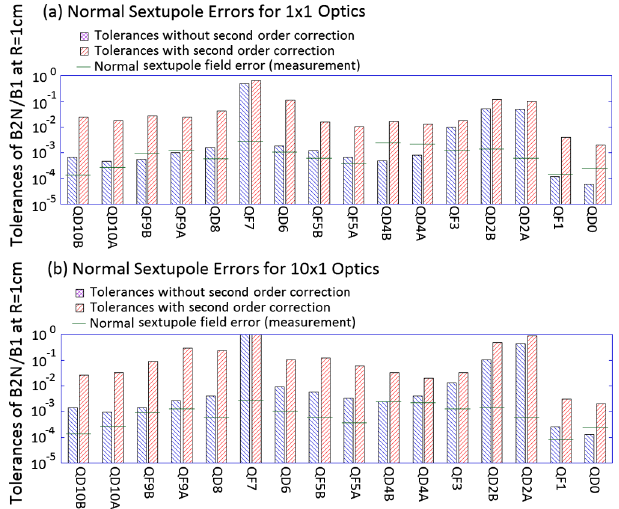
FIG. 11. Tolerances of normal sextupole field errors for quadrupole magnets in the 1 × 1 optics (a) and the 10 × 1 optics (b). The tolerances are defined by the requirement to induce a 2% IP vertical beam size growth, and the tolerances with and without second order knob corrections are shown. The measured normal sextupole field errors are also shown.